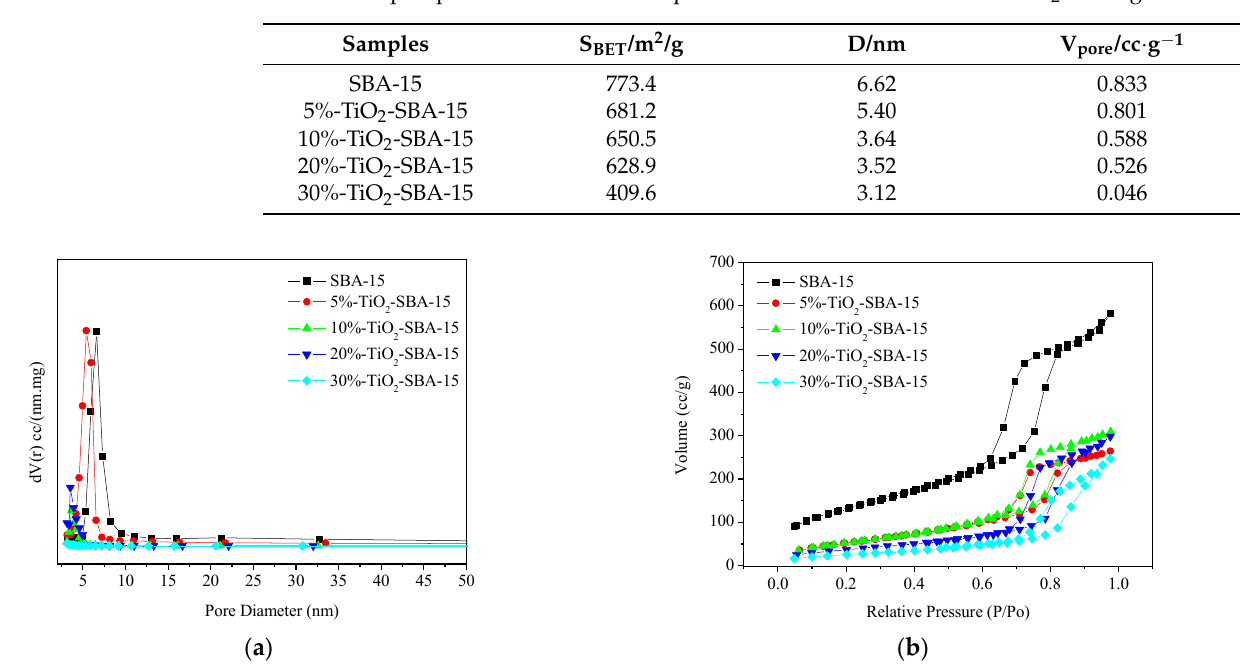
Figure 4. ( a ) Pore size curves calculated from the BJH equivalent cylindrical model, ( b ) N 2 adsorption-desorption isotherms.